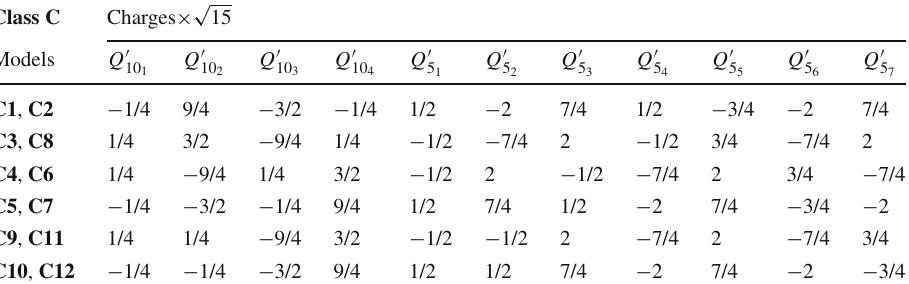
Table 14 U ( 1 ) (cid:2) charges of Class C models. The charges are multiplied with